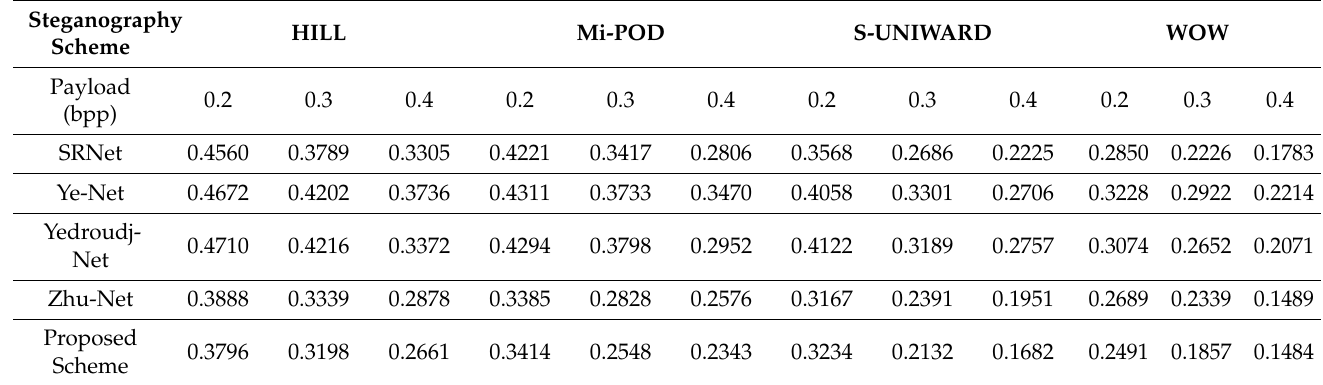
Table 6. Detection errors of the proposed and other schemes using BOSSBase image set.